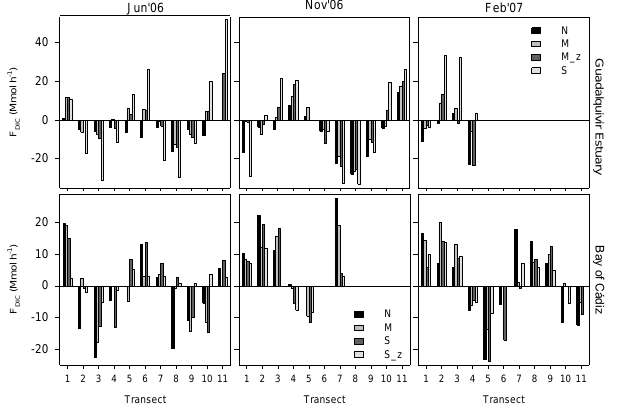
Fig. 6. Daily variations in dissolved inorganic carbon fluxes ( F DIC ) during June, November and February in the Guadalquivir estuary (upper panels) and the Bay of C´adiz (lower panels) at the different sampling stations.